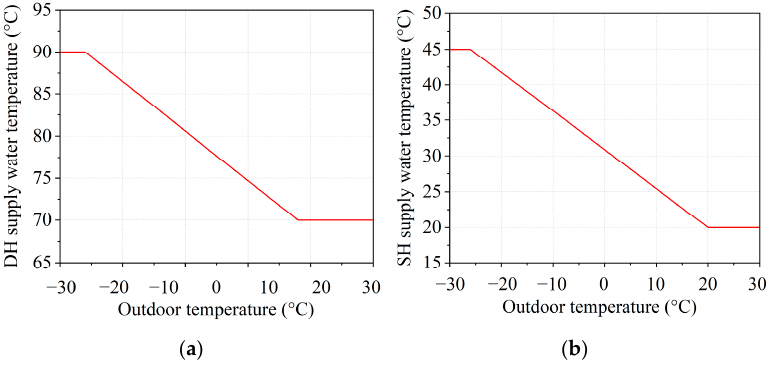
Figure 2. ( a ) Inlet water temperature control curve for DH as a function of outdoor temperature; ( b ) inlet water temperature control curve for space heating (SH) as a function of outdoor temperature.